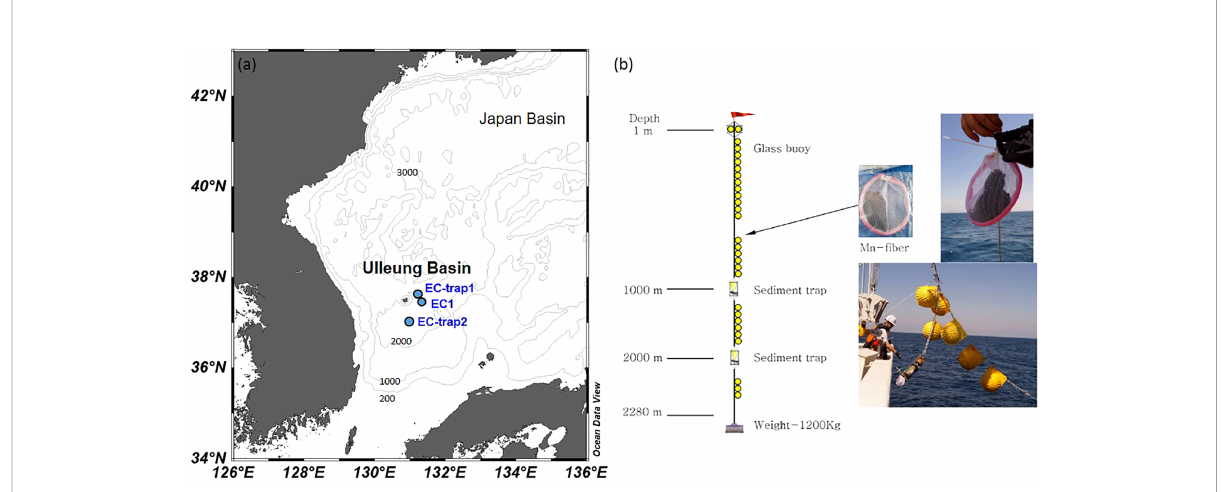
FIGURE 1 (A) Geographic locations of Ra mooring stations (blue circle) in the Ulleung Basin (UB) of the East Sea (Japan Sea) in 2017. (B) A simpli fi ed schematic of the mooring system (left) and photographs of Mn- fi ber mesh bags attached to the mooring line